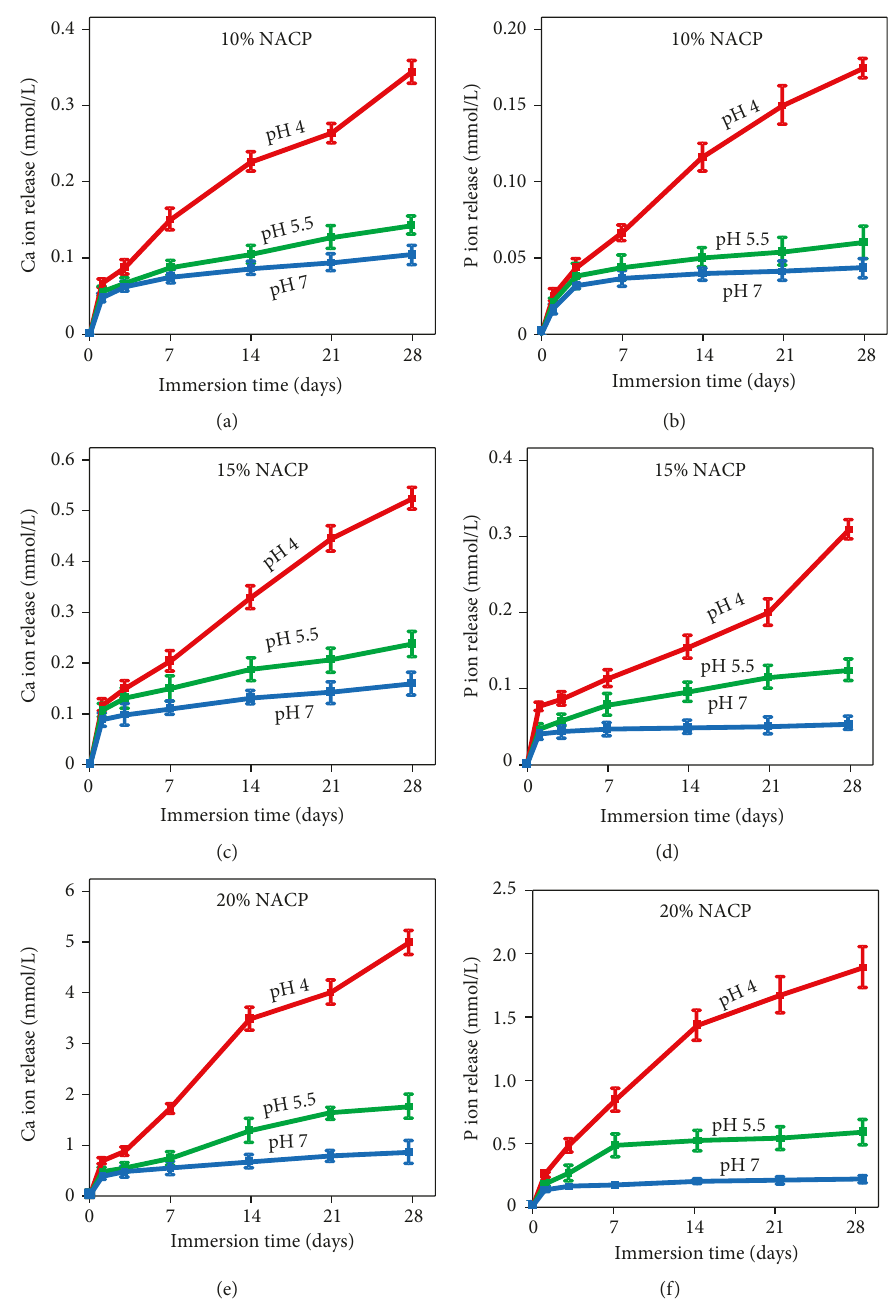
Figure 5: Calcium (Ca) and phosphate (P) ion release ( mean ± sd ; n = 3 ) from the VT fi lled with: (a, b) 10% NACP, (c, d) 15% NACP, and (e, f) 20% NACP. Ion release increased with increasing the immersion time and the NACP fi ller level. Ion release increased with decreasing the solution pH. (Adapted from reference [49], with